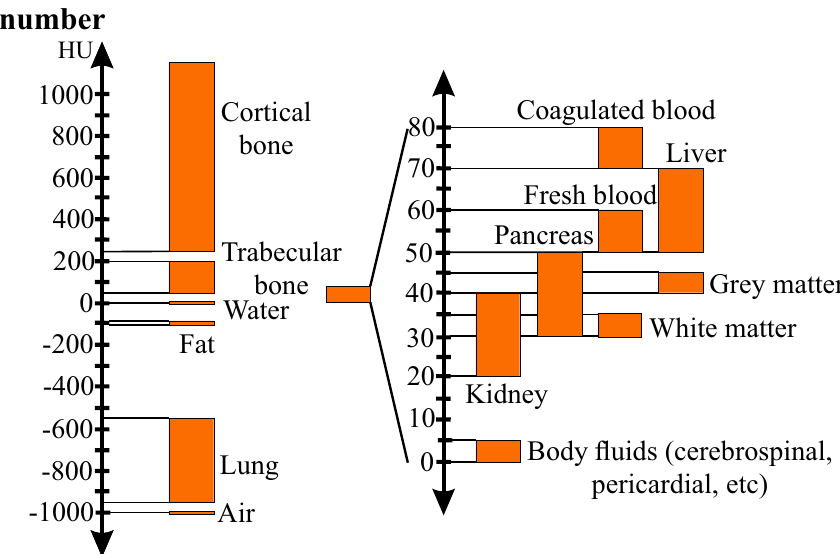
Figure 2. Hounsfield-Scale for different kinds of tissues (adapted from c (cid:13) Institut für Anatomie, Universität Bern (https://elearning.medizin.unibe.ch/morphomed/radioanatomie/ct-